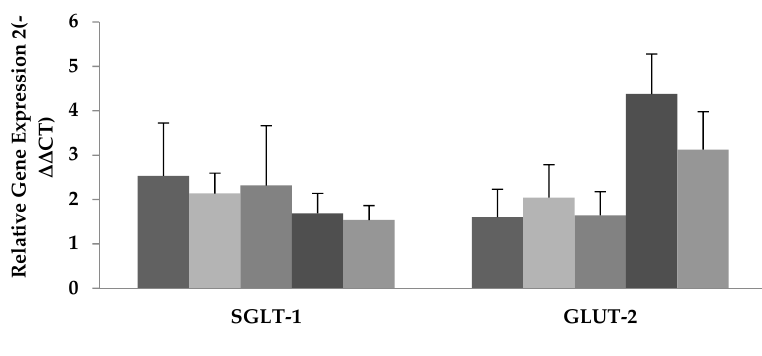
Figure 3. E ff ect of Cr-CNPs supplementation on gene expression of glucose transporters, i.e., (left side) SGLT-1, and (right side) GLUT-2 in broilers. Data are presented as mean ± SEM. Group A = control—without Cr-CNPs supplementation. Group B = o ff ered 200 µ g Cr-CNPs / kg of feed. Group C = o ff ered 400 µ g Cr-CNPs / kg of feed. Group D = o ff ered 800 µ g Cr-CNPs / kg of feed. Group E = o ff ered 1200 µ g Cr-CNPs / kg of feed.